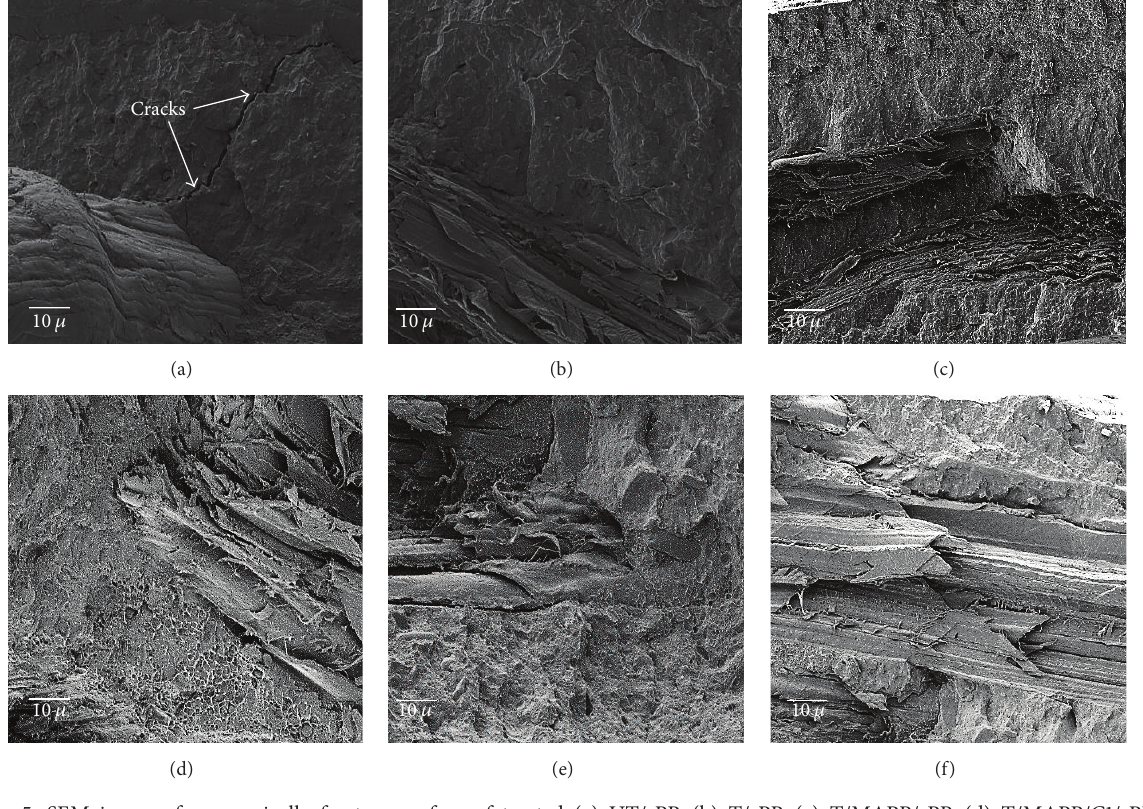
Figure 5: SEM image of cryogenically fracture surface of treated (a) UT/rPP, (b) T/rPP, (c) T/MAPP/rPP, (d) T/MAPP/C1/rPP, (e) T/MAPP/C3/rPP, and (f) T/MAPP/C5/rPP, composites.